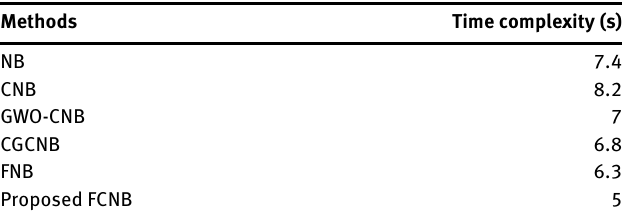
Table 3: Time Complexity of the Comparative Methods.